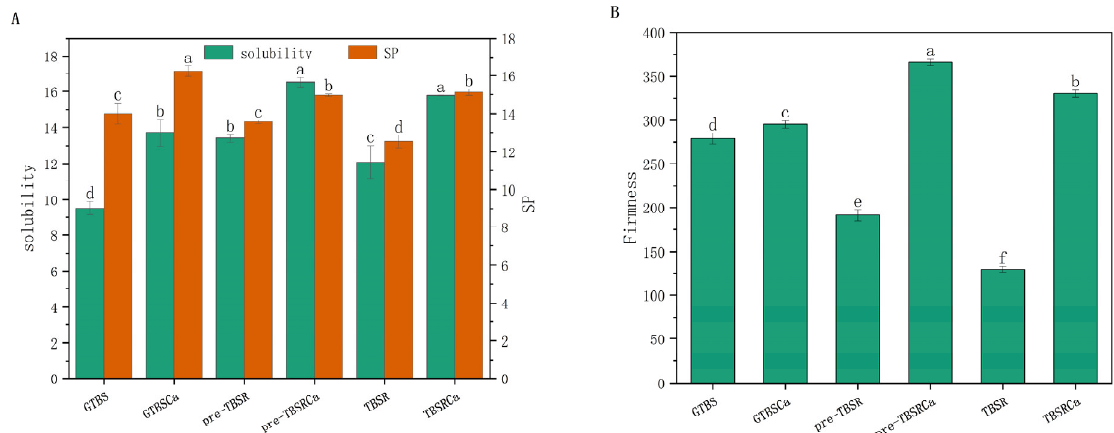
Figure 1. SP and solubility of each sample ( A ); gel firmness of heat-treated Tartary buckwheat starch and starch complexes for 1 day ( B ). Different lowercase letters within the same color column represent significantly different ( p < 0.05).